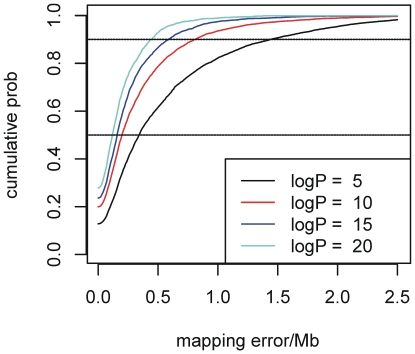
Distributions of the mapping error in QTL location for QTL in which logPMAX is 5, 10, 15, or 20.Each curve is estimated from simulations as described in Materials and Methods. The width of the corresponding confidence interval is twice the mapping error. The horizontal dashed lines cut the distributions at the 50% (lower) and 90% (upper) points.